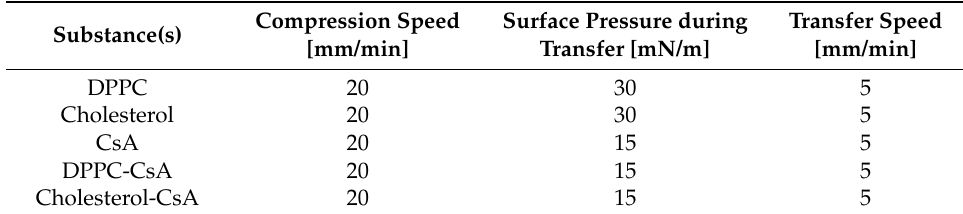
Table 1. Experimental transferring